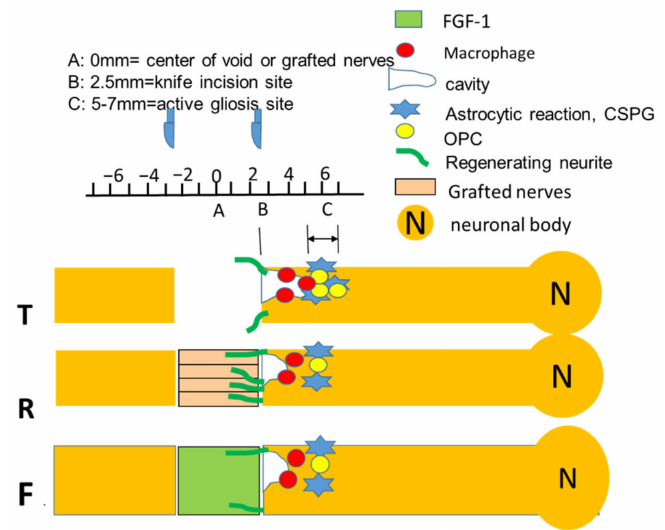
Figure 1. A diagram demonstrating the distance of incision site (B, marked 2.5) from the injury center (A, marked 0), as well as area that we previously consistently detect reactive gliosis and data from this paper collected (C, marked 5–7). (Details see Section